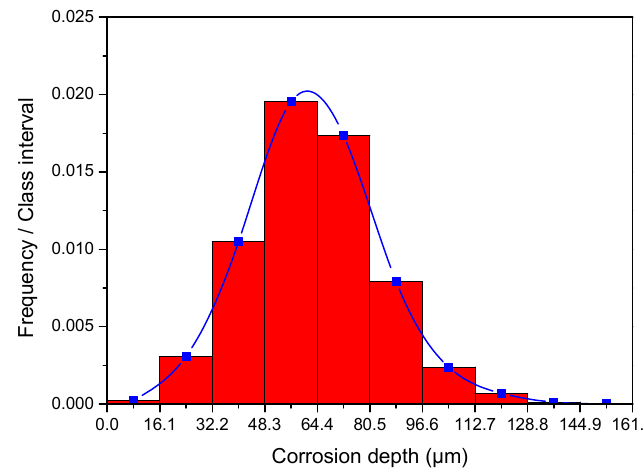
Figure 10. Frequency density distribution of corrosion depth on the surface of the sample corroded at 800 m after the removal of corrosion scales.